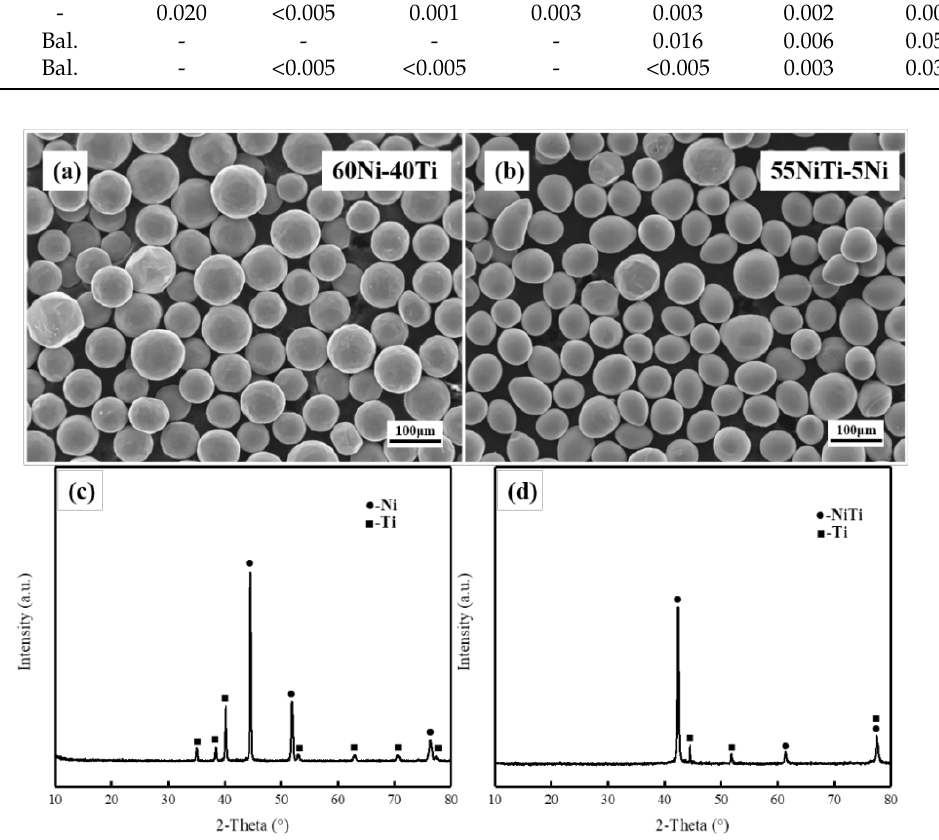
Figure 1. Scanning electron microscopy (SEM) images and X-Ray diffraction (XRD) patterns of mixed powders: ( a ), ( c ) 60Ni-40Ti; ( b ), ( d ) 55NiTi-5Ni. Table 1. The nominal composition of the powders ( wt %).